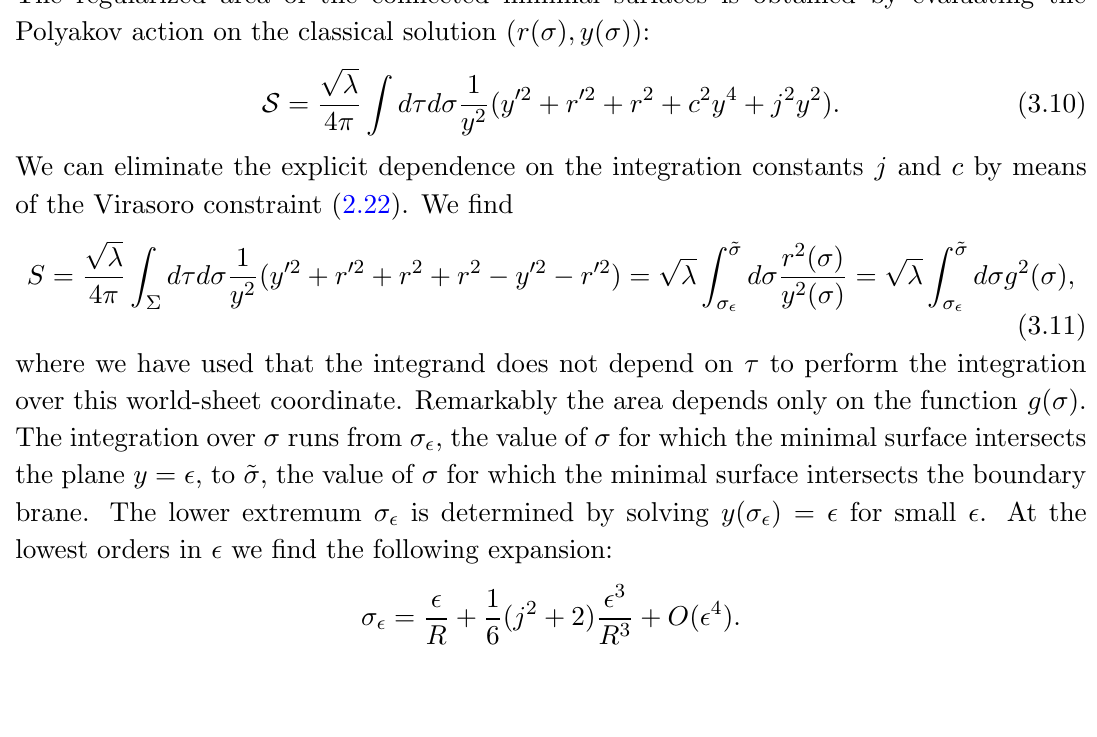
Figure 8. The dashed curves are given by eq. (3.9) and describe the distance for (cid:31) (cid:20) (cid:31) the continuous ones are valid for (cid:31) > (cid:31) . Di(cid:11)erent colors correspond to di(cid:11)erent (cid:13)uxes. We see (cid:20) 2 that the maximal distance grows both with (cid:31) and (cid:20) 2 . We have drawn the dashed curves also for values greater than (cid:31) to show that the merging of the two branches is continuous with its (cid:12)rst (cid:20) 2